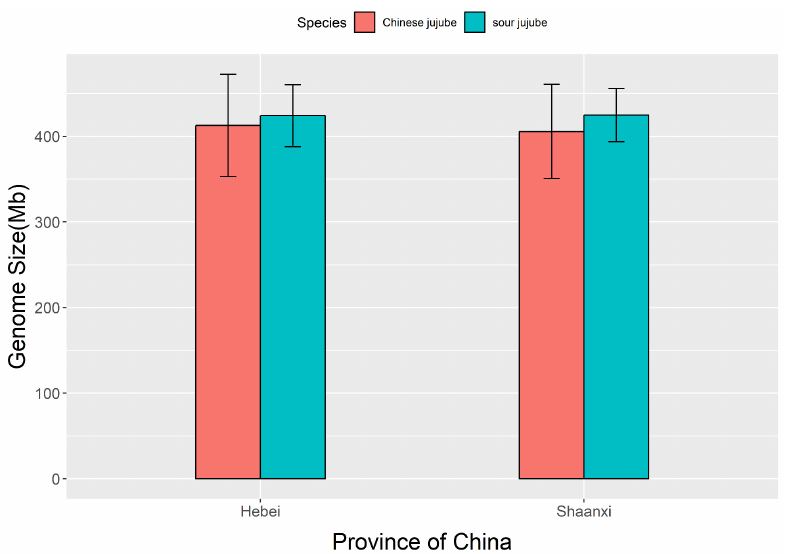
Figure 11. Comparison of average genome sizes of Chinese jujube and sour jujube from Hebei and Shaanxi provinces.